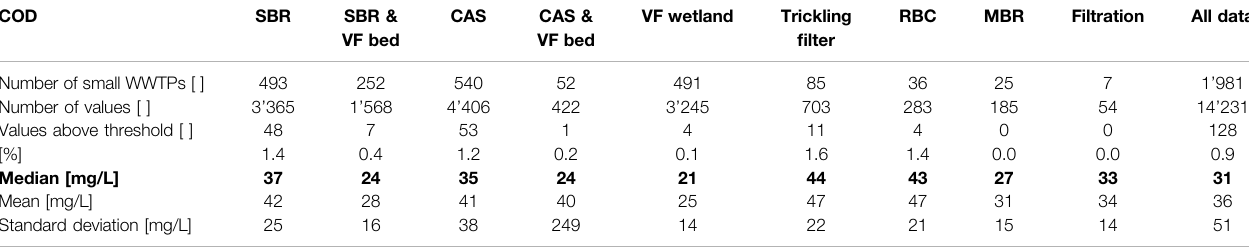
Bold values indicate the median